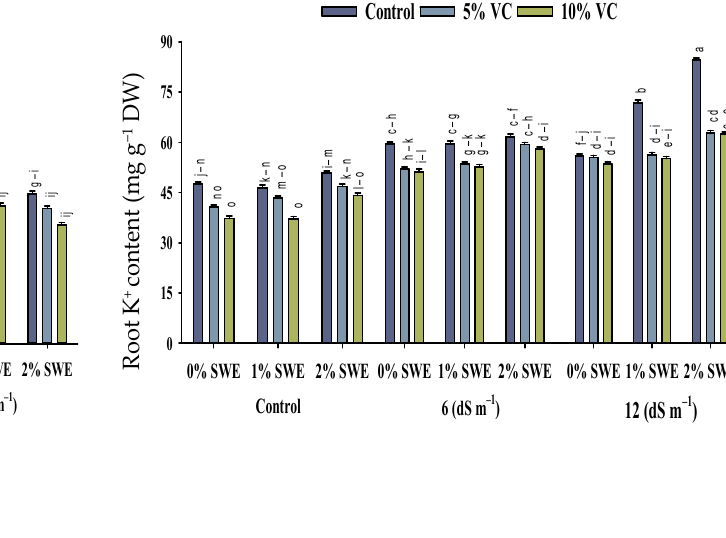
Figure 4. Hydrogen peroxide (H 2 O 2 ) (µmol g − 1 FW; a ) and malondialdehyde (MDA) (µmol g − 1 FW; b ) contents in the leaf of maize as affected by various treatments of vermicompost (VC), sorghum water extract (SWE) under control, moderate salinity (6 dS m − 1 ), and high salinity (12 dS m − 1 ). Error bars depict the standard error of 3 replications ( n = 3). Bars with the same letters do not differ sig- nificantly ( p ≤ 0.05).